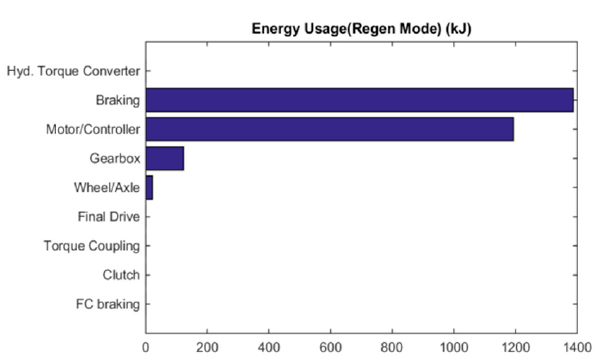
Figure 8. Energy use regeneration (regen) mode.